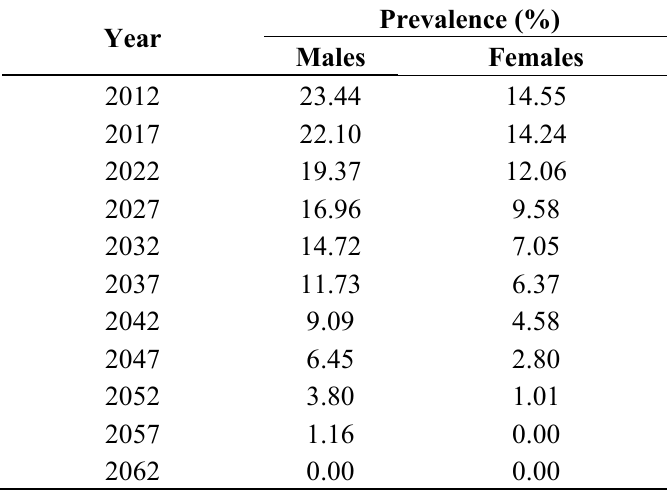
Table 2. Projections on the smokers prevalence (%) for males and